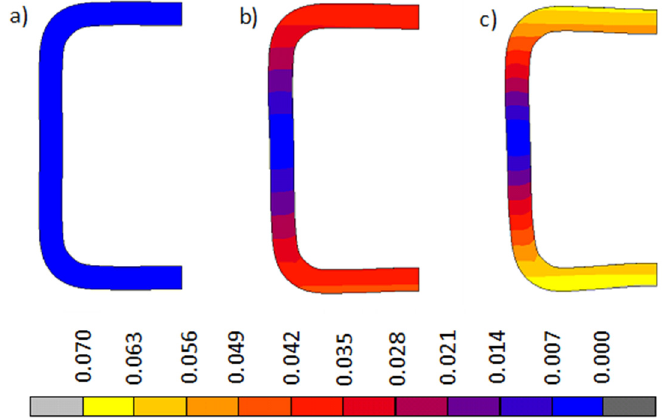
Figure 8. Change in cross-sectional shape of the bent beam (model B) and distribution of total substitute plastic deformations for: ( a ) 1/R = 0 m − 1 , ( b ) 1/R = 4 m − 1 , and ( c ) 1/R = 6 m − 1 .